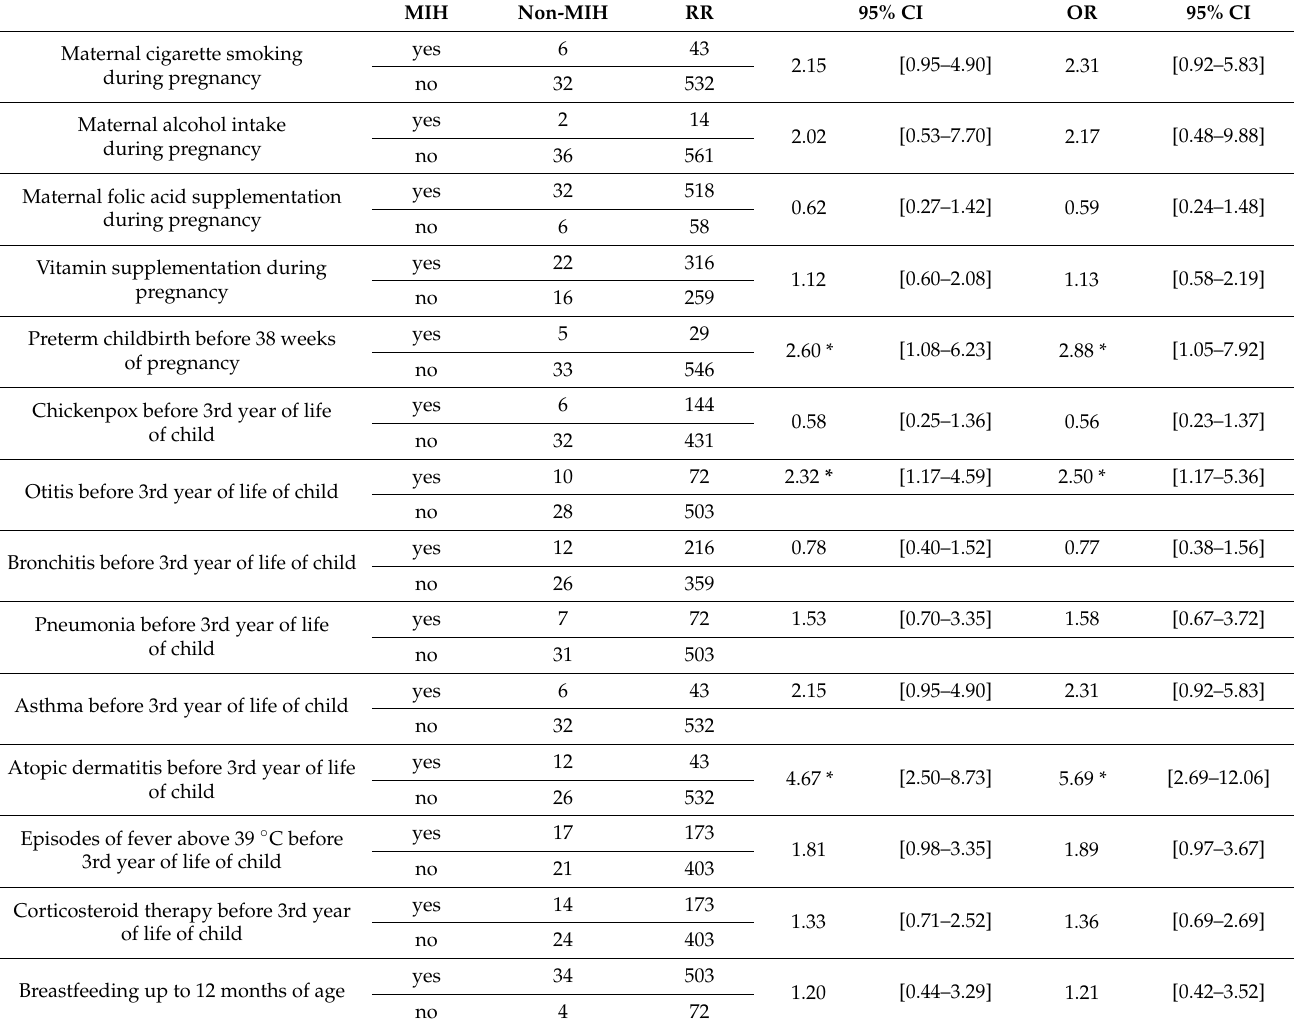
Table 7. The distribution of potential etiological environmental factors in the MIH and non- MIH groups. MIH Non-MIH RR 95% CI OR 95%